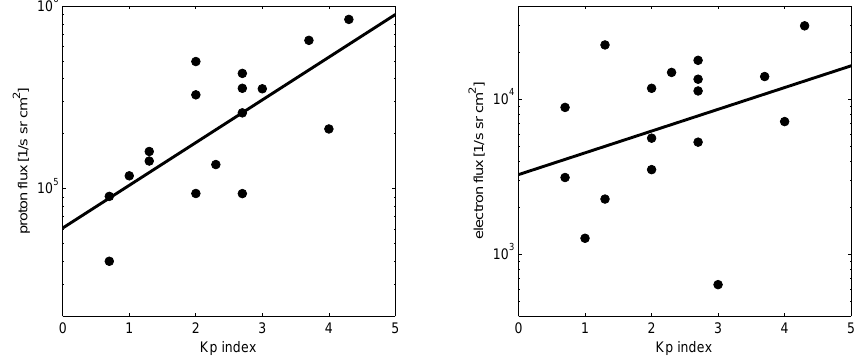
Fig. 14. Energetic particle fluxes in the HLPS as a function of K P index. Left: protons, right: